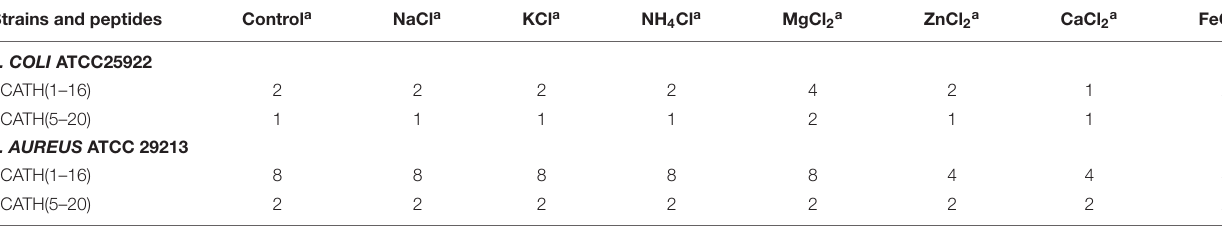
TABLE 3 | MIC values of peptides in the presence of physiological concentration salts. Strains and